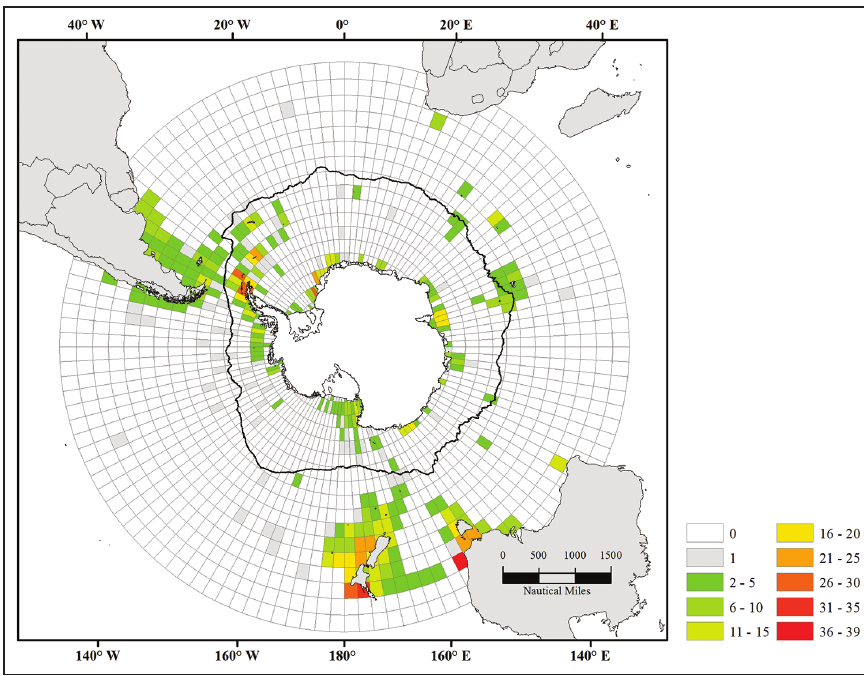
Figure 2a. Number of species recorded per grid cell